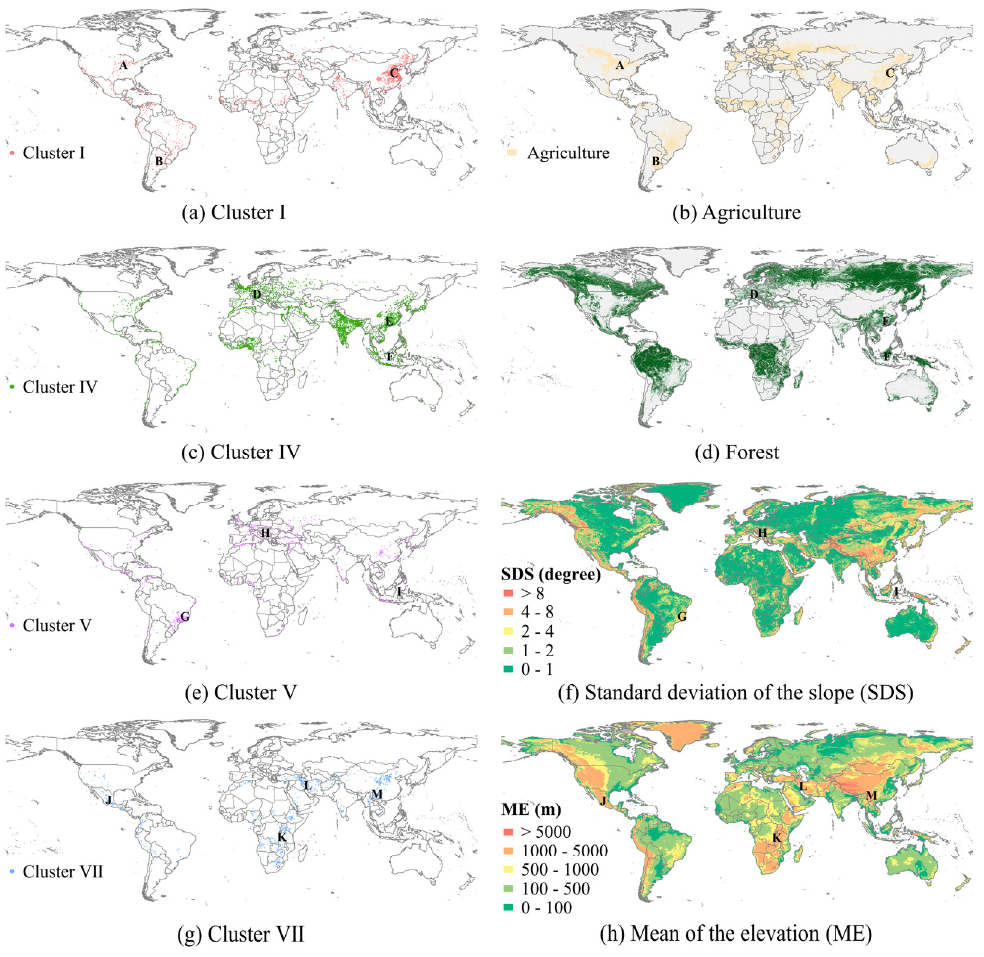
Figure 5. Comparison of the spatial patterns of the four typical clusters, i.e., ( a ) Cluster I, ( c ) Cluster IV, ( e ) Cluster V and ( g ) Cluster VII, with those of the four geographical factors, i.e., ( b ) agriculture, ( d ) forest, ( f ) standard deviation of the slope and ( h ) mean of the elevation. (3)